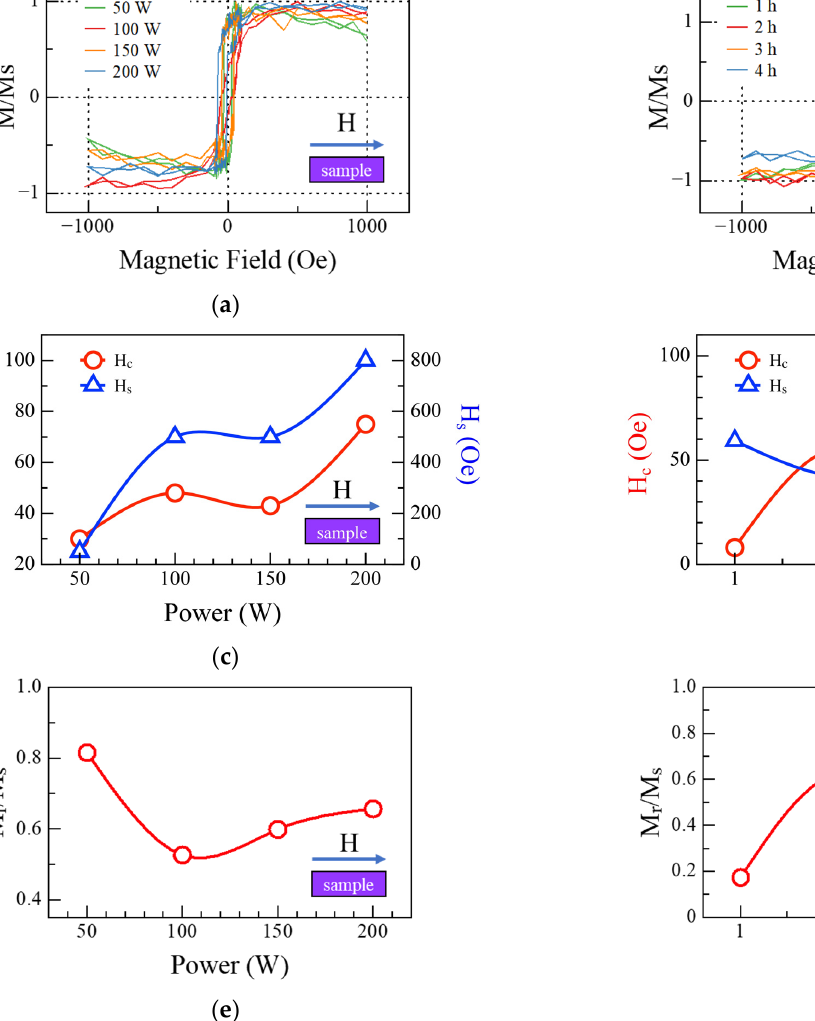
Figure 5. Sputtering power effect and deposition time effect on ( a , b ) in-plane hysteresis loop, ( c , d ) coercivity ( H c ) and saturated magnetic field strength ( H s ), and ( e , f ) the remanence ratio ( M r / M s ) of TbDyFe film.